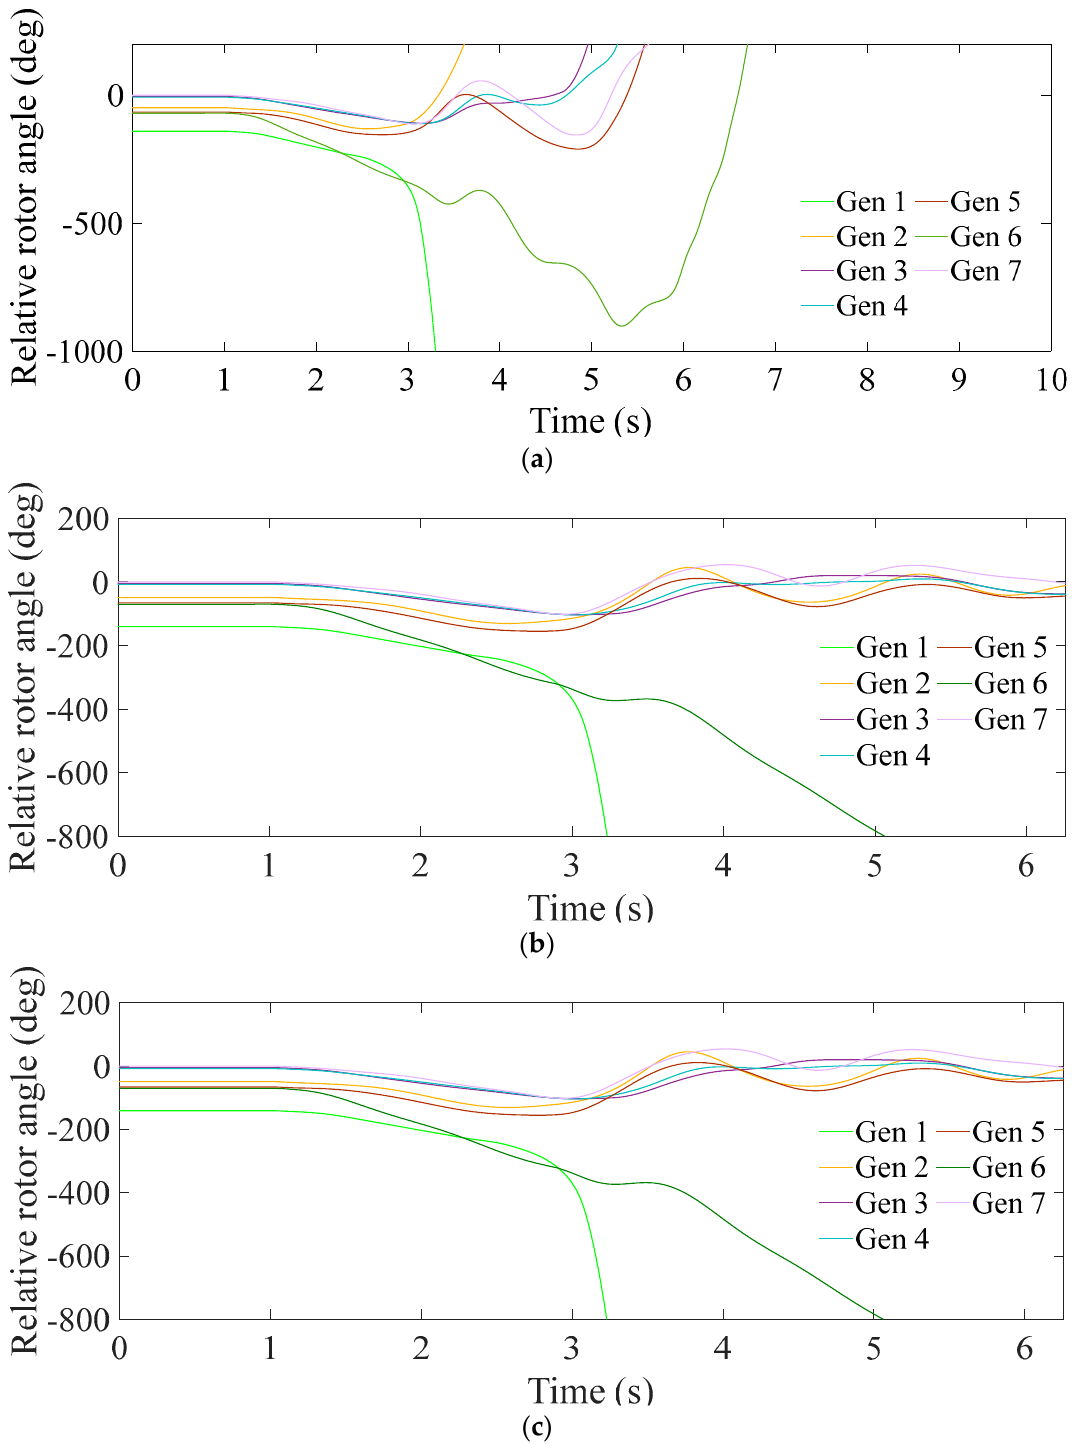
Figure 10. The RRA of a set of generators in Contingency 2: ( a ) Case 1, ( b ) Case 2, and ( c ) Case 3.